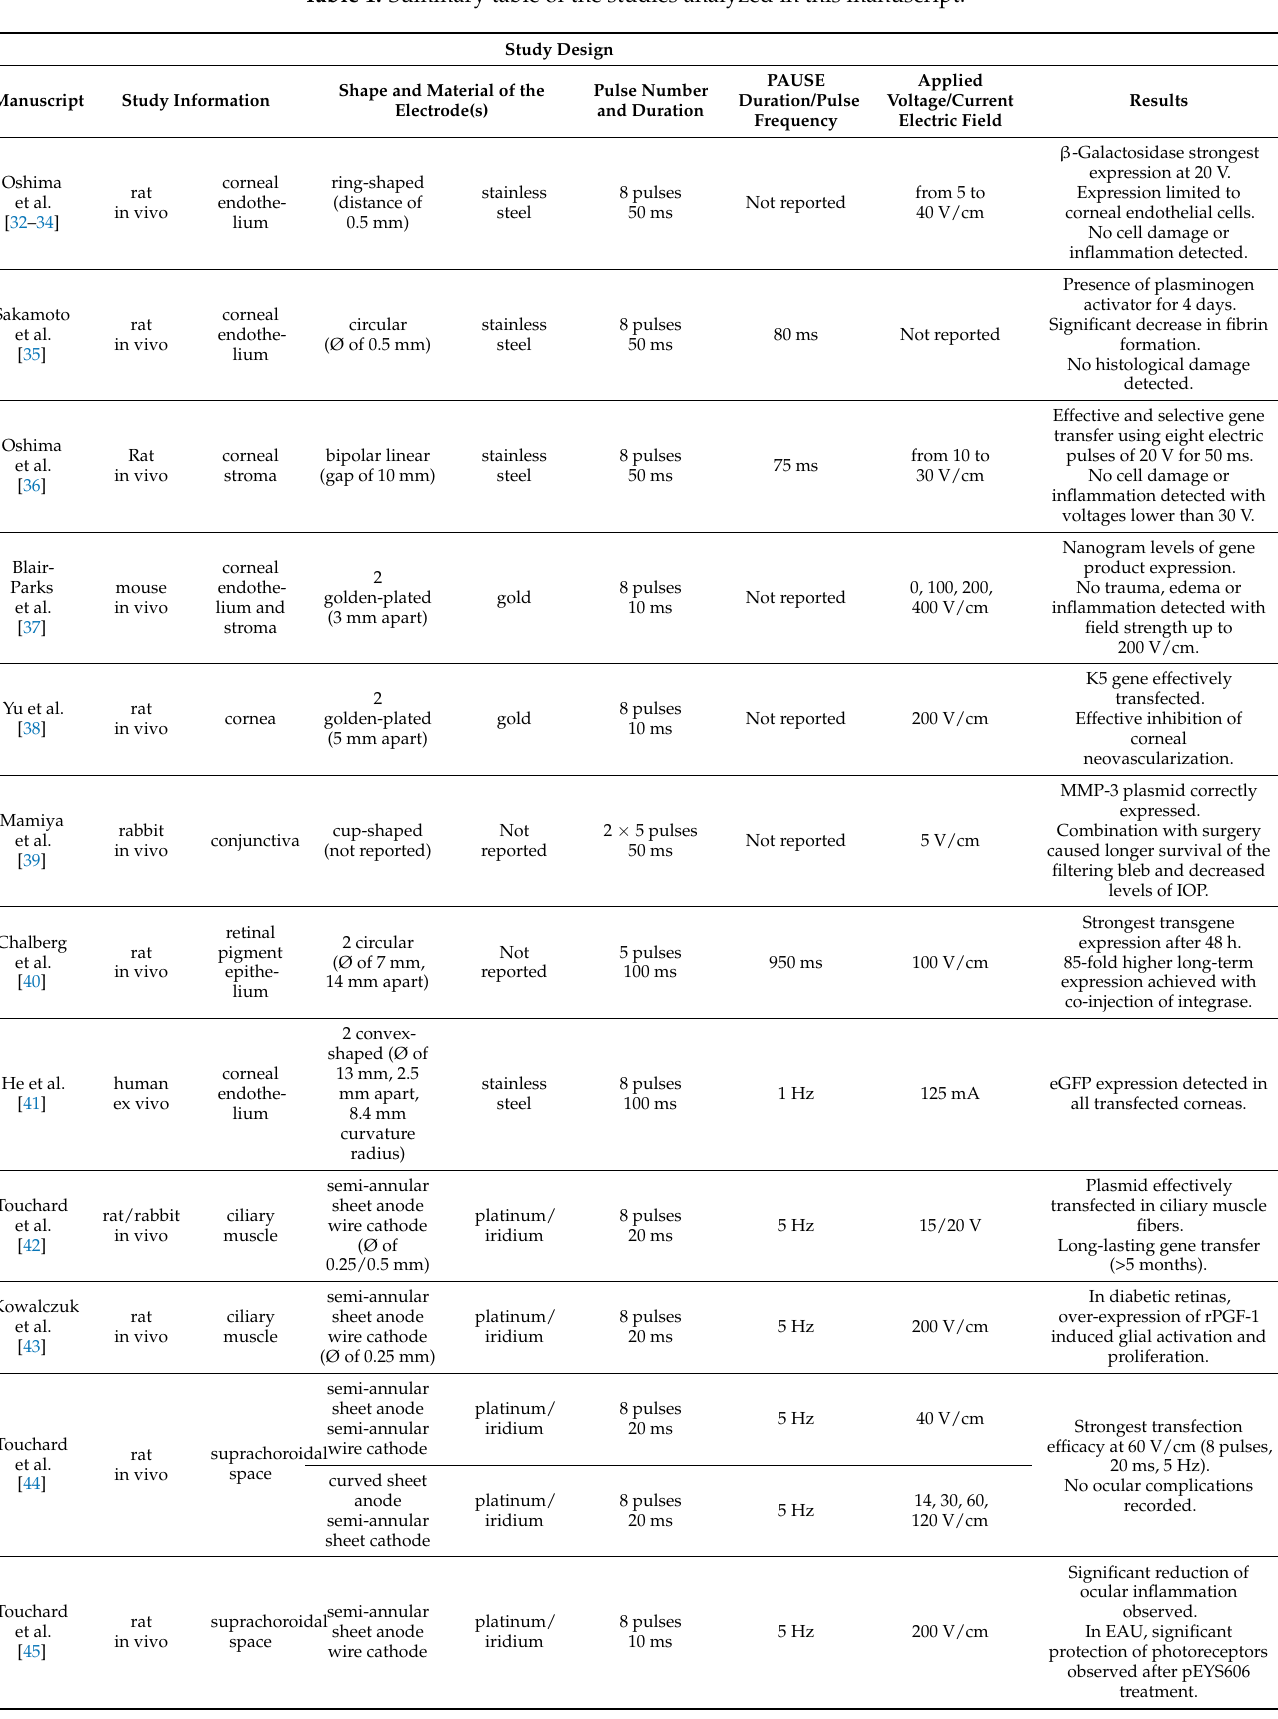
Table 1. Summary table of the studies analyzed in this